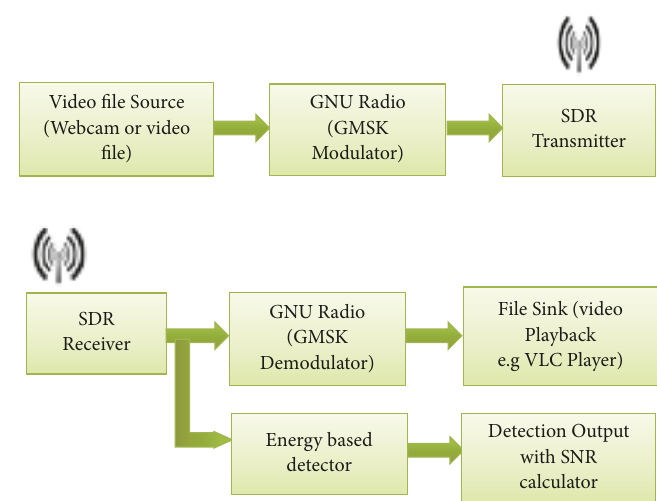
Figure 2: Overall block diagram transmitter and receiver for energy based spectrum sensing.